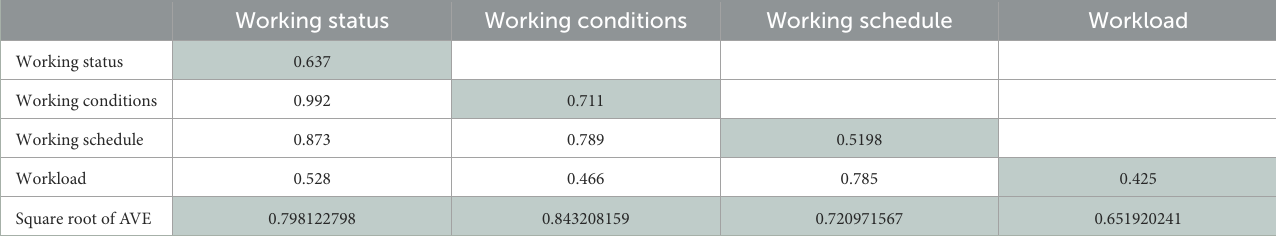
TABLE 9 Correlation coefficients between factors affecting fatigue in long-haul flight pilots’ “work”